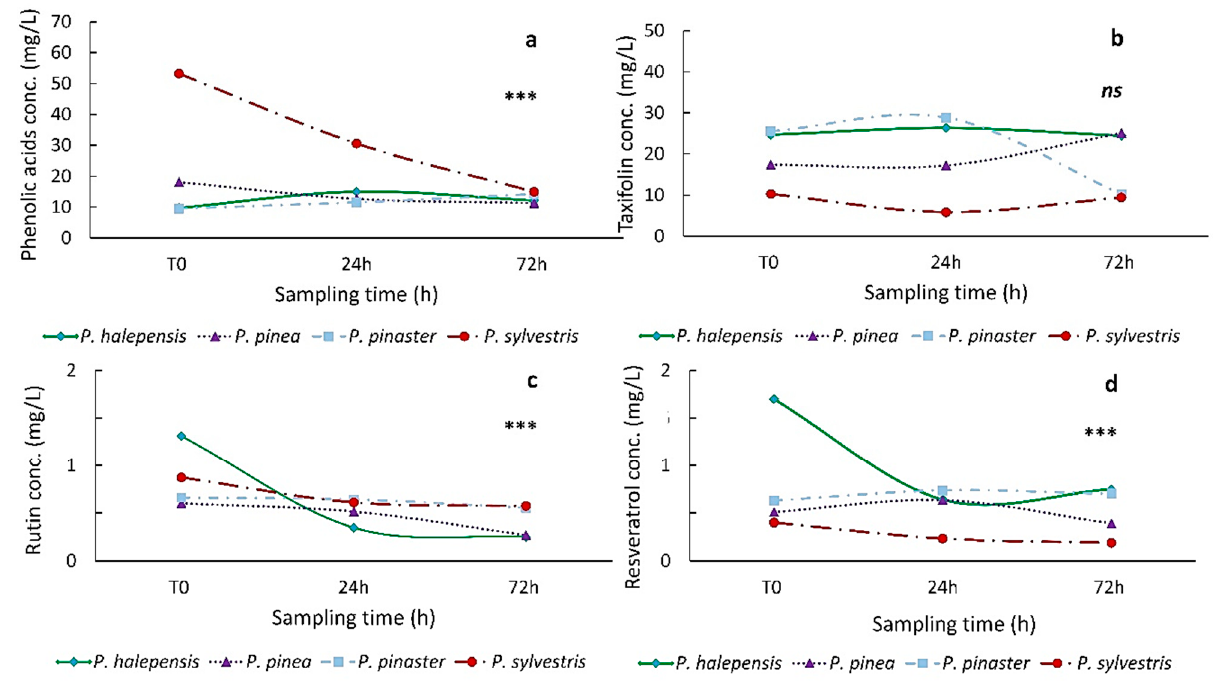
Figure 3. Plot of means two-way interaction (species x sampling time, ANOVA test) for phenolic acids ( a ), taxifolin ( b ), rutin ( c ), and resveratrol ( d ) in water-inoculated trees. Significant differences are indicated by an asterisk (*** p < 0.01 and ns —without significant difference).